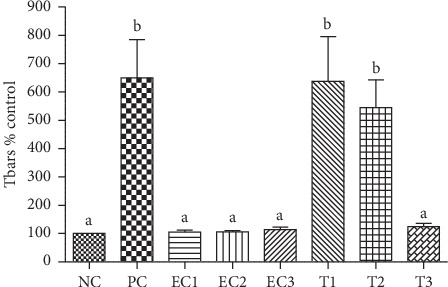
NC: Negative Control (buffer solution); PC: Positive Control (FS = Ferrous sulfate) (FS 13.9 μg/mL); Extract control (EC1: Extract Control 10 μg/mL; EC2: Extract Control 100 μg/mL; EC3: Extract Control 1000 μg/mL); and treatment (T1: FS 13.9 μg/mL + extract 10 μg/mL; T2: FS 13.9 μg/mL + extract 100 μg/mL; T3: FS 13.9 μg/mL + extract 1000 μg/mL). Different letters represent statistical differences according to the Tukey test (p < 0.0001).